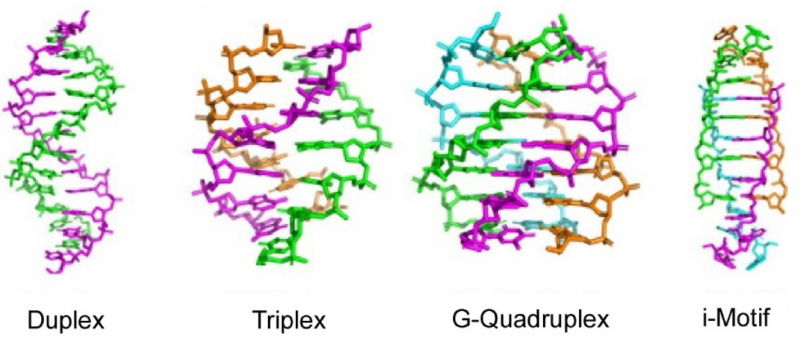
Non-double helix (non-canonical) DNA nanoarchitectures such as triplexes, G- quadruplexes, and i-motifs. Reprinted with permission from Reference [136]. Copyright 2021 Chemical Society of